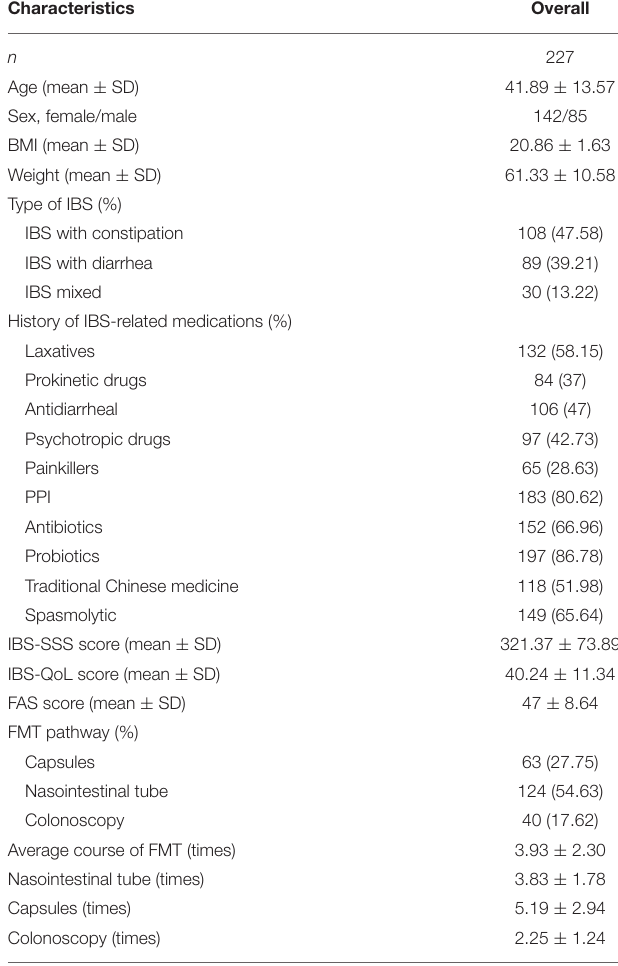
TABLE 1 | Baseline characteristics of